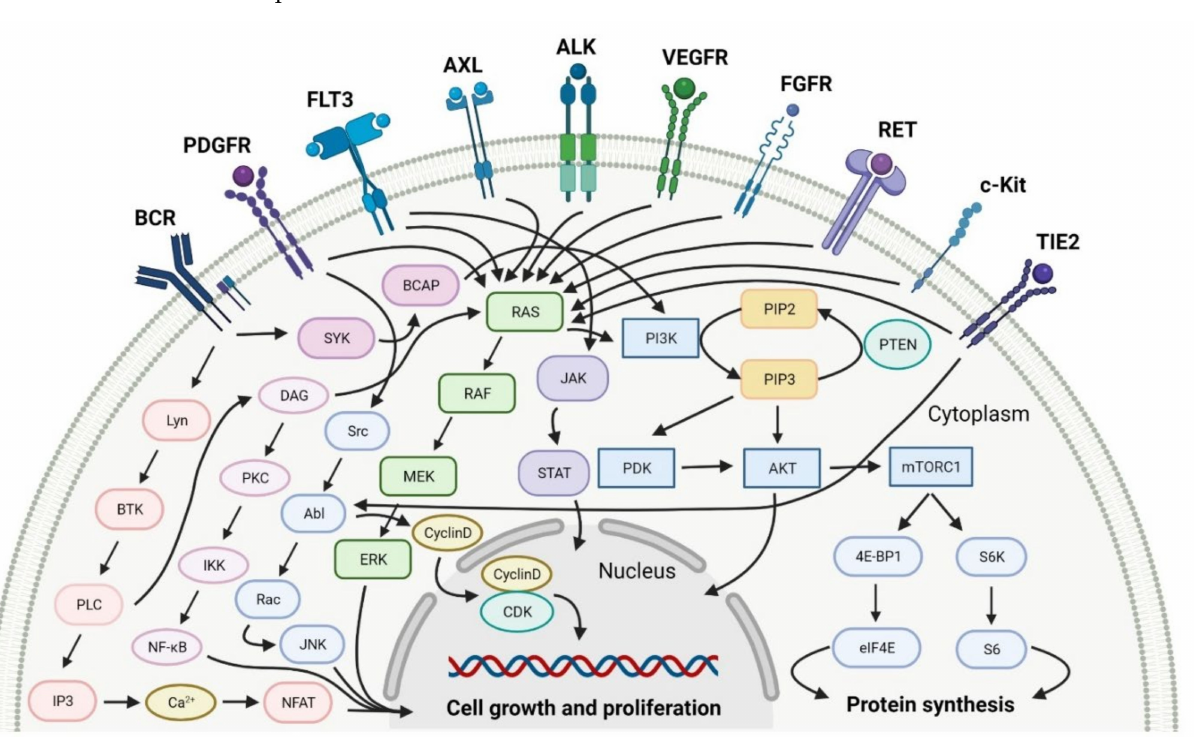
Figure 2. Schematic representation of the signaling pathways that can potentially be inhibited by multi kinase inhibitors. BCR : B-cell receptor. PDGFR : platelet-derived growth factor receptor. FLT3 : FMS-like tyrosine kinase-3. AXL : AXL receptor tyrosine kinase. ALK : anaplastic lymphoma ki- nase. VEGFR : vascular endothelial growth factor receptor. FGFR : fibroblast growth factor receptor. RET : receptor tyrosine kinase rearranged during transfection. c-Kit : mast/stem cell growth fac- tor receptor. TIE2 : tunica interna endothelial cell kinase 2. PI3K : phosphatidylinositol 3-kinase. PIP2 : phosphatidylinositol 4,5-bisphosphate. PIP3 : phosphatidylinositol-3,4,5-trisphosphate. PTEN : phosphatase and tensin homolog deleted on chromosome ten. PDK : 3-phosphoinositide-dependent protein kinase. AKT : protein kinase B. mTORC1: mammalian target of rapamycin complex 1. 4E- BP1 : 4E-binding protein 1. eIF4E : eukaryotic translation initiation factor 4E. S6K : p70S6 kinase. S6 : S6 protein. RAF : proto-oncogene serine/threonine-protein kinase. MEK : mitogen-activated protein kinase kinase. ERK : mitogen-activated protein kinase. Src : non-receptor Sarcoma kinase. Abl : Abelson kinase. Rac : Ras-related C3 botulinum toxin substrate. JNK : c-Jun N-terminal kinase. CDK : cyclin-dependent kinase. SYK : spleen tyrosine kinase. BCAP : B cell adapter for PI3K. DAG : diacylglycerol. PKC : protein kinase C. IKK : I κ B kinase. NF- κ B : nuclear factor kappa-light-chain- enhancer of activated B cells. Lyn : tyrosine-protein kinase Lyn. BTK : Bruton’s tyrosine kinase. PLC : phospholipase C. IP3 : inositol trisphosphate. NFAT : nuclear factor of activated T-cells. Created with BioRender.com based on information in